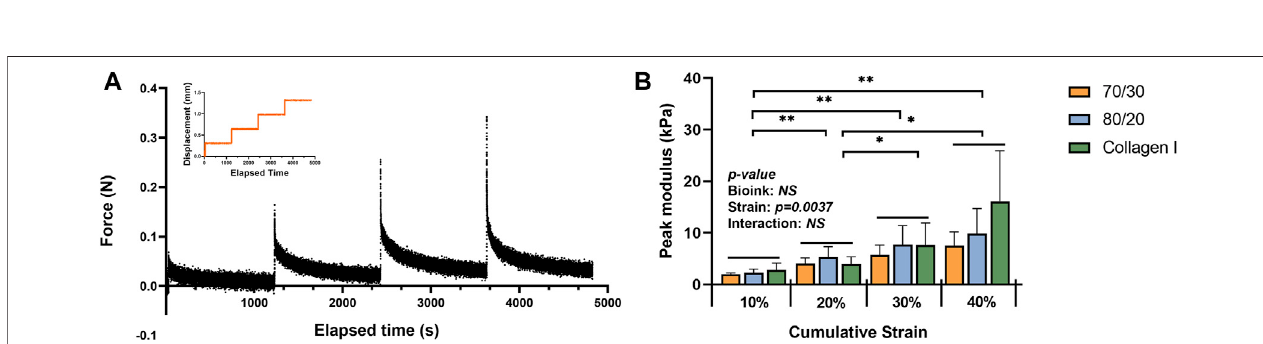
FIGURE 9 | Mechanical properties of the bioprinted constructs: (A) an example of data acquisition of the strain-controlled uncon fi ned compression test (B) the peak modulus as a function of the cumulative strain ( n (cid:1) 3). * represents p < 0.05.